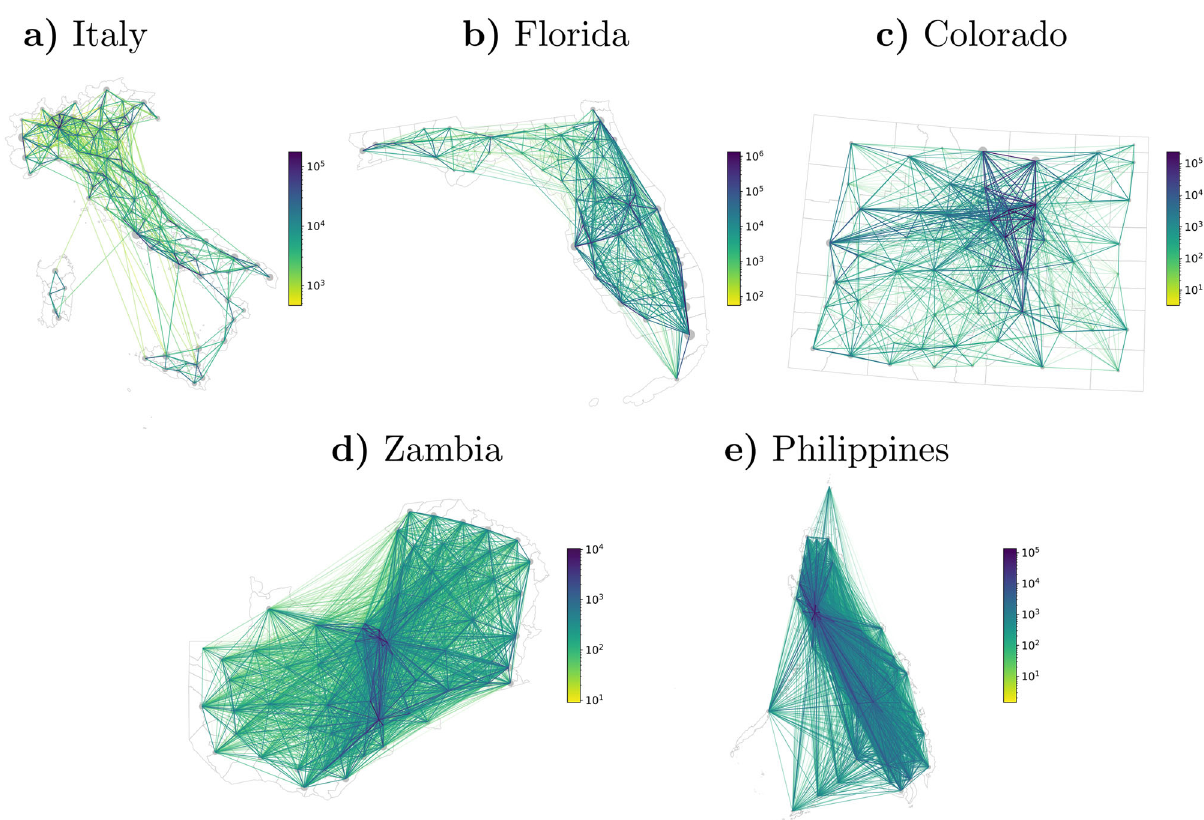
Fig. 4 Real human mobility fl ows used in this study. Metapopulation networks consisting of empirical populations (nodes) and empirical human fl ows (links) are shown, embedded in space (coordinates are given by longitude and latitude), in the case of ( a ) Italy; ( b ) Florida (USA); ( c ) Colorado (USA); ( d ) Zambia; ( e ) The Philippines. For Italy, Florida and Colorado fl ows are movements between provinces or counties, estimated using anonymized GPS trajectories of mobile apps users and upscaled to the total population. For Zambia and the Philippines, fl ows are migrations between administrative units reconstructed through gravity modeling 53 . The intensity of edge colors is proportional to the observed fl ows, while node sizes are proportional to the local